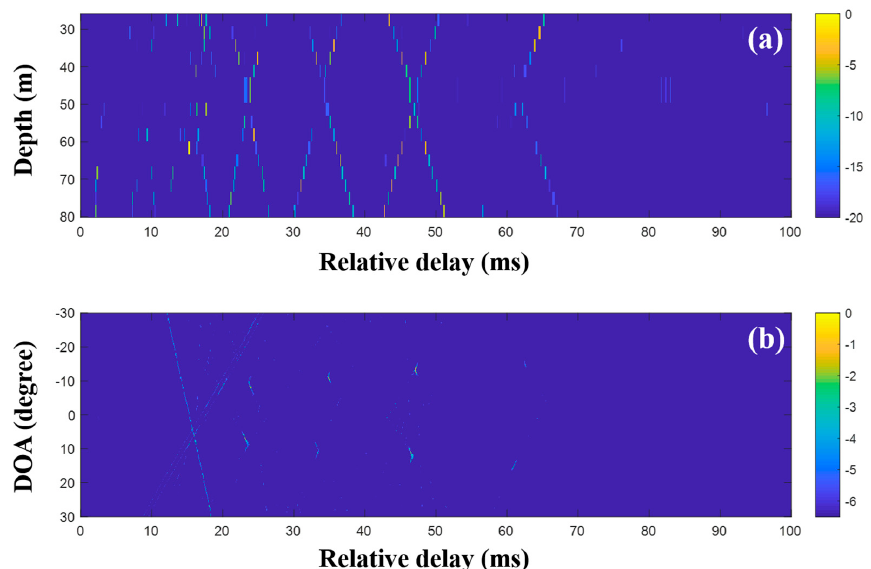
Figure 10. Direction-of-arrival (DOA) estimation using expanded compressive sensing (CS) with multiple measurements when the Doppler effect occurs. The signal-to-noise ratio (SNR) is − 9.8 dB: ( a ) arrival structures via sequential CS usage with the signals at the vertical line array (VLA). The compressive time delay estimation (TDE) using the common time delays of the arrivals over the multiple measurements is applied. ( b ) DOAs using delay-and-sum beamforming with the arrival structures.